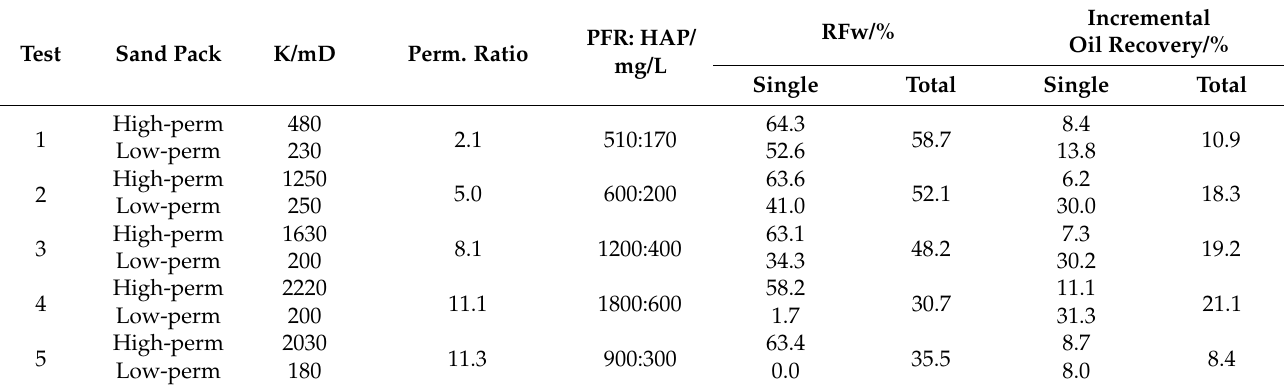
Table 2. Oil recovery of PFR/HAP dispersion flood for parallel sand